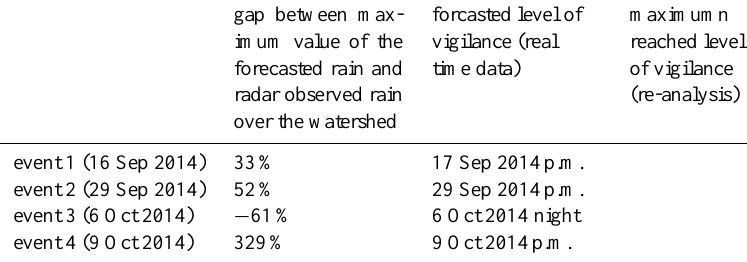
Table 2. Uncertainty on the forecasted rainfall and flood level of